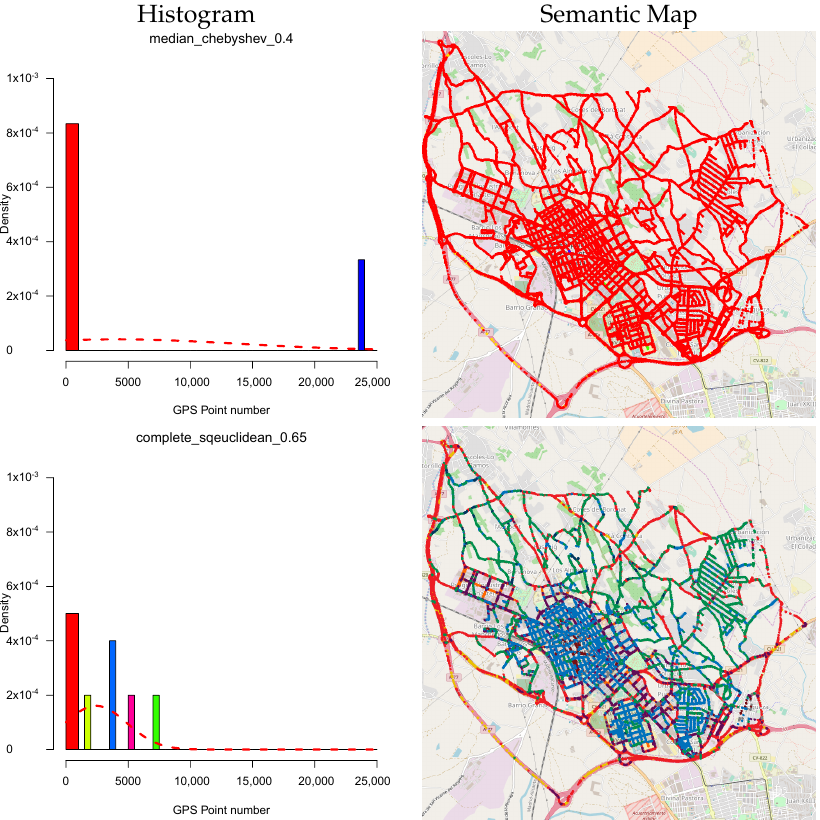
Figure 8. Density histogram ( left ) for semantic maps ( right ), generated using the proposed method. Histograms represent the density of clusters with the number of GPS points indicated in the x -axis. The higher number of bars on the left-hand side of the chart indicates a high number of clusters containing less than half the number of GPS points in the dataset. This may be understood as a feature of a good map. The cluster and bars colors indicate no relation between the